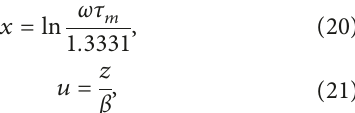
Figure 3: The normalized dependences of the relaxation compo- nents of the decrement on the inverse temperature δ KH (for better clarity, the data for three samples are given). The dashed line shows the normalized dependence of the relaxation component of the decrement obtained for the sample Zr-02CE in the single relaxation time approximation